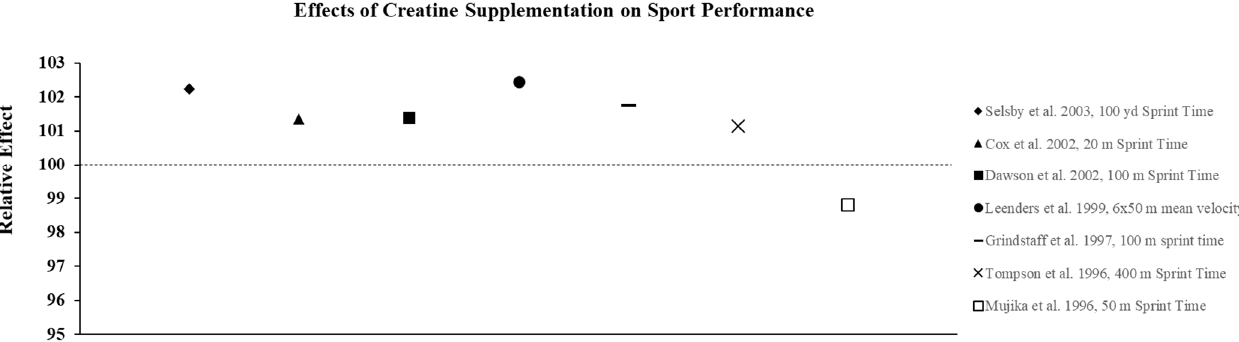
Figure 4. The relative effects of creatine supplementation in comparison to placebo on sports performance in females.